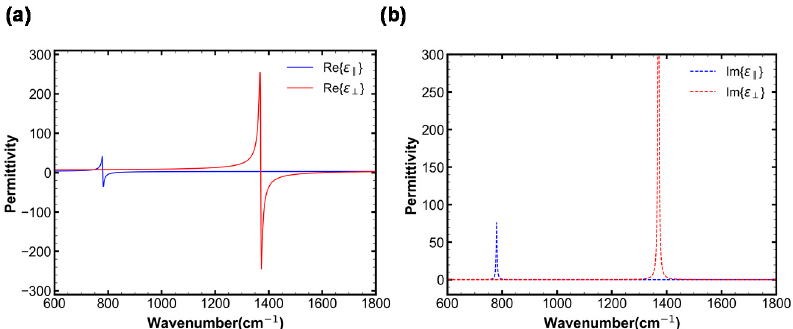
Figure 4. ( a ) Real and ( b ) imaginary parts of the permittivities of hBN.